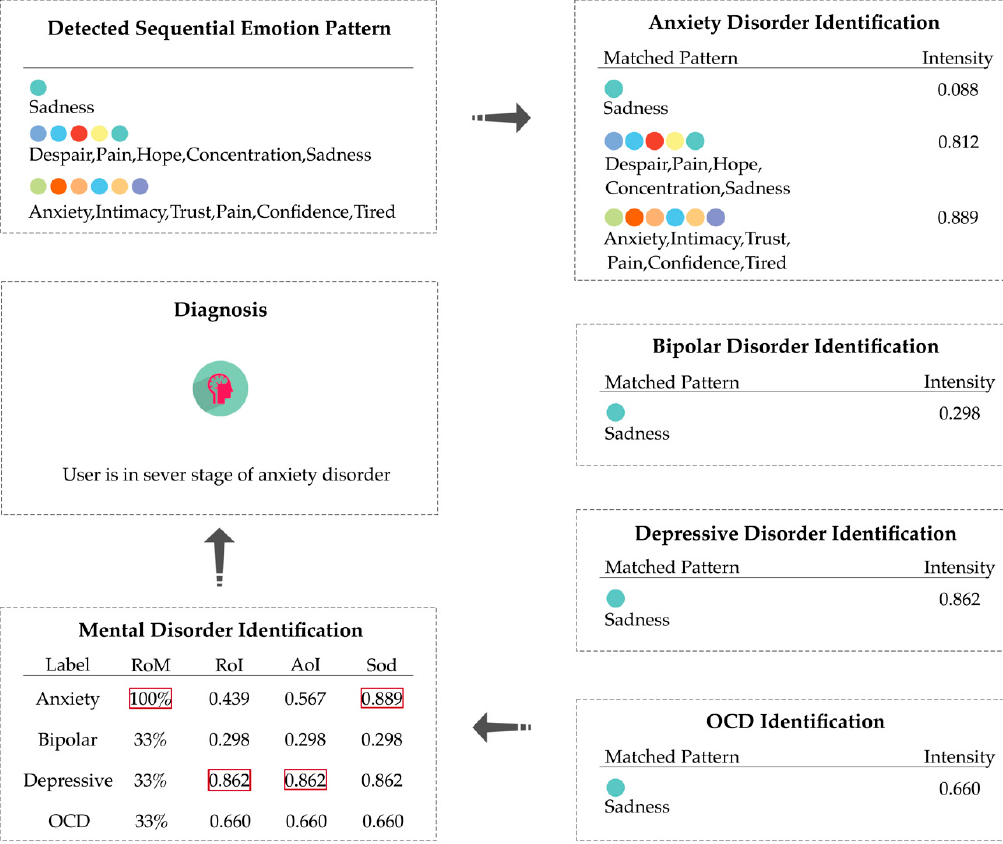
Figure 5. The identification process of the MDI ‐ Model.